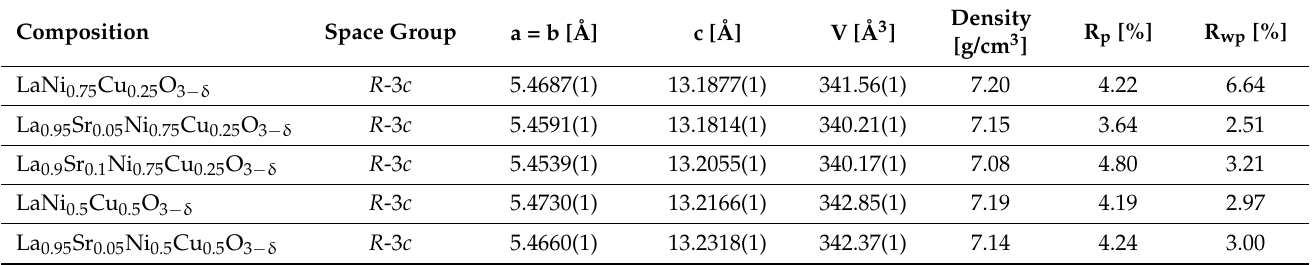
Table 1. Rietveld refinement results for as-synthesized La 1 − x Sr x Ni 1 − y Cu y O 3 − δ oxides.